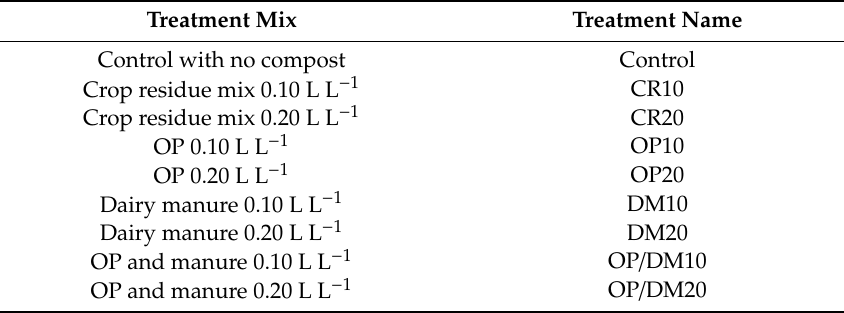
Table 4. Compost and rate treatment combinations used in Experiment